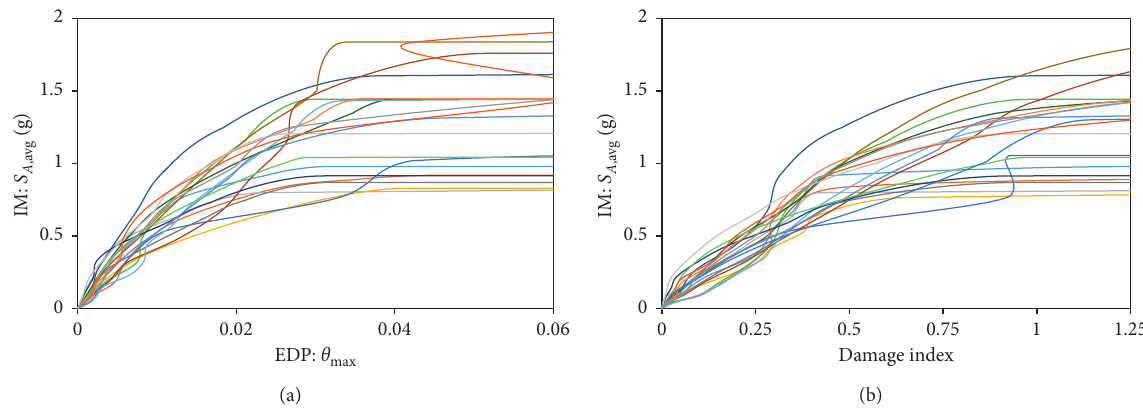
Figure 9: Damage analysis of the symmetric model: (a) interstory drift ratio versus S